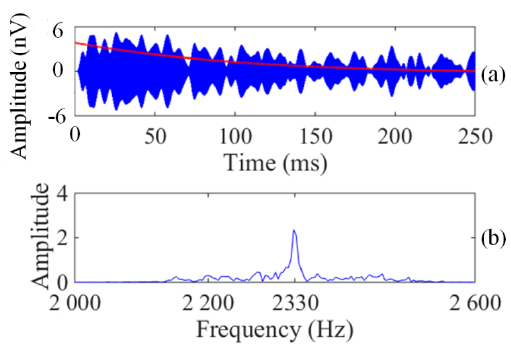
Figure 16. The results for the CSMN system. ( a ) Time domain signals (the blue curves) and envelope fitting curve (the red one); ( b ) Frequency domain signals.